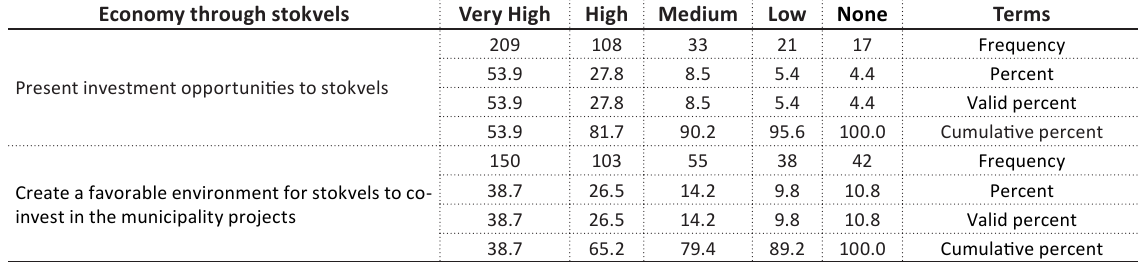
Table 4. Response on the municipality transforming the economy through stokvels